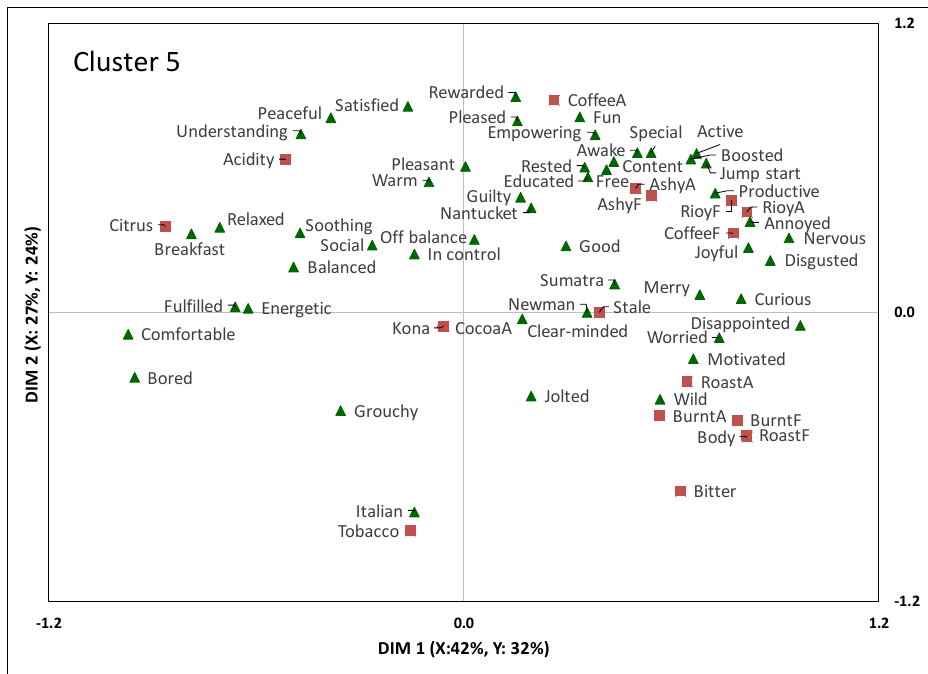
Figure 7. Partial least square regression analysis of descriptive sensory and CDE emotion lexicon of the six coffee samples for consumer Cluster 5.